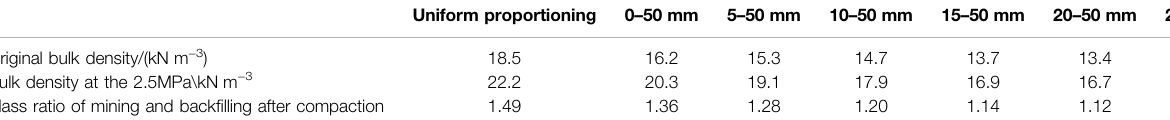
TABLE 2 | Variation of bulk density of gangue samples in different stages.